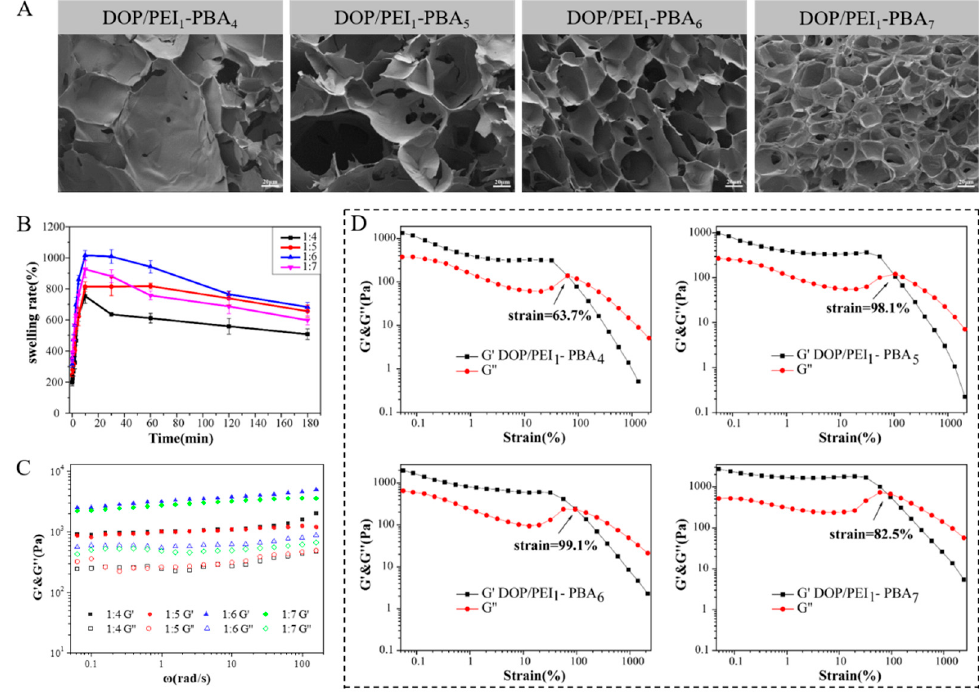
Figure 3. Characterization of DOP/PEI-PBA hydrogels: SEM images ( A ), swelling ratios ( B ), rheological analysis of DOP/PEI-PBA hydrogel in frequency sweep mode ( C ) and strain sweep mode ( D ) of hydrogels with different ratios of PEI to PBA.